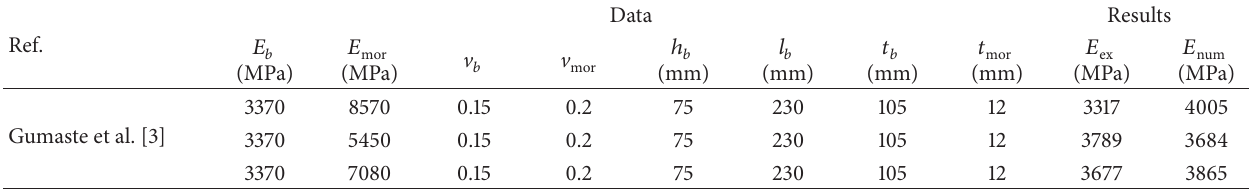
Table 7: Gumaste data and experiment and numerical results.